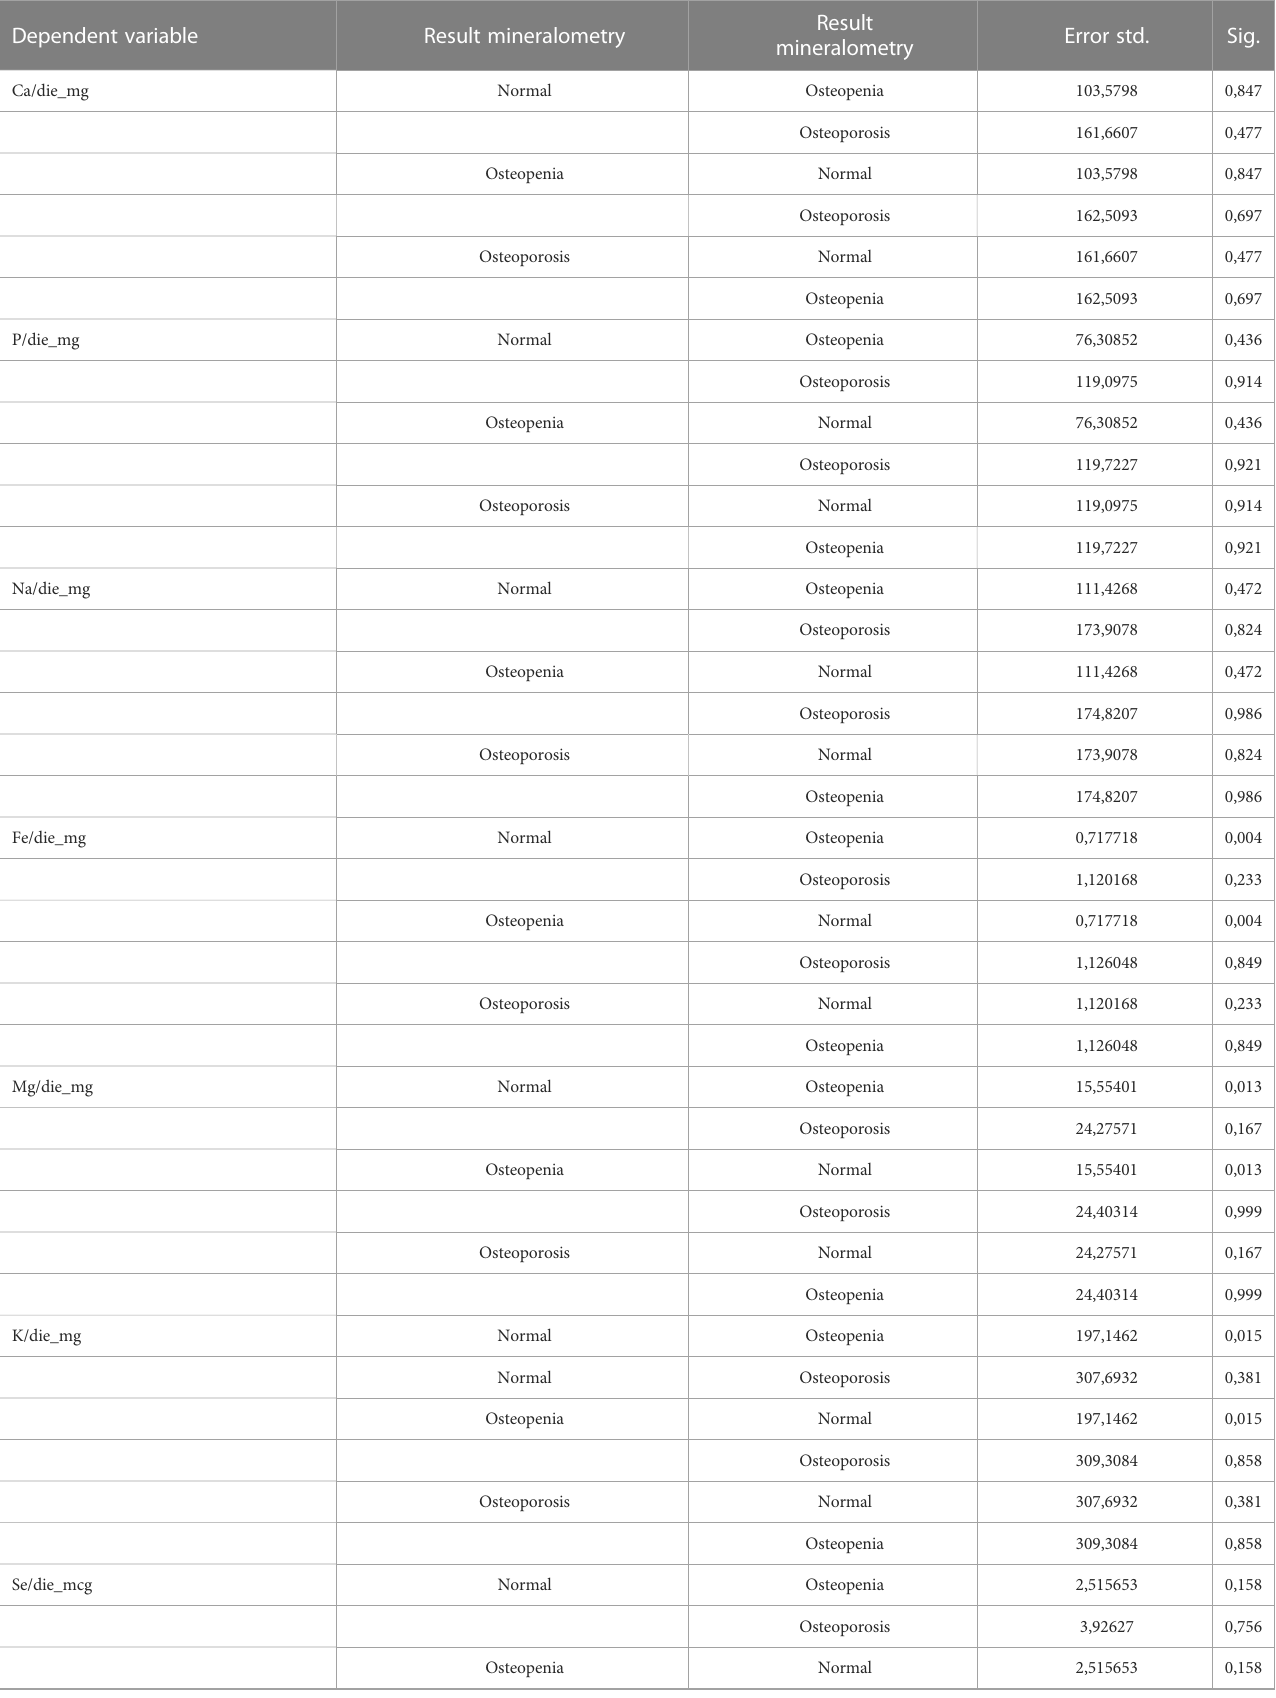
TABLE 10 ANOVA univariata study of the differences in food consumption between subjects with normal bone density, osteopenic e osteoporotic